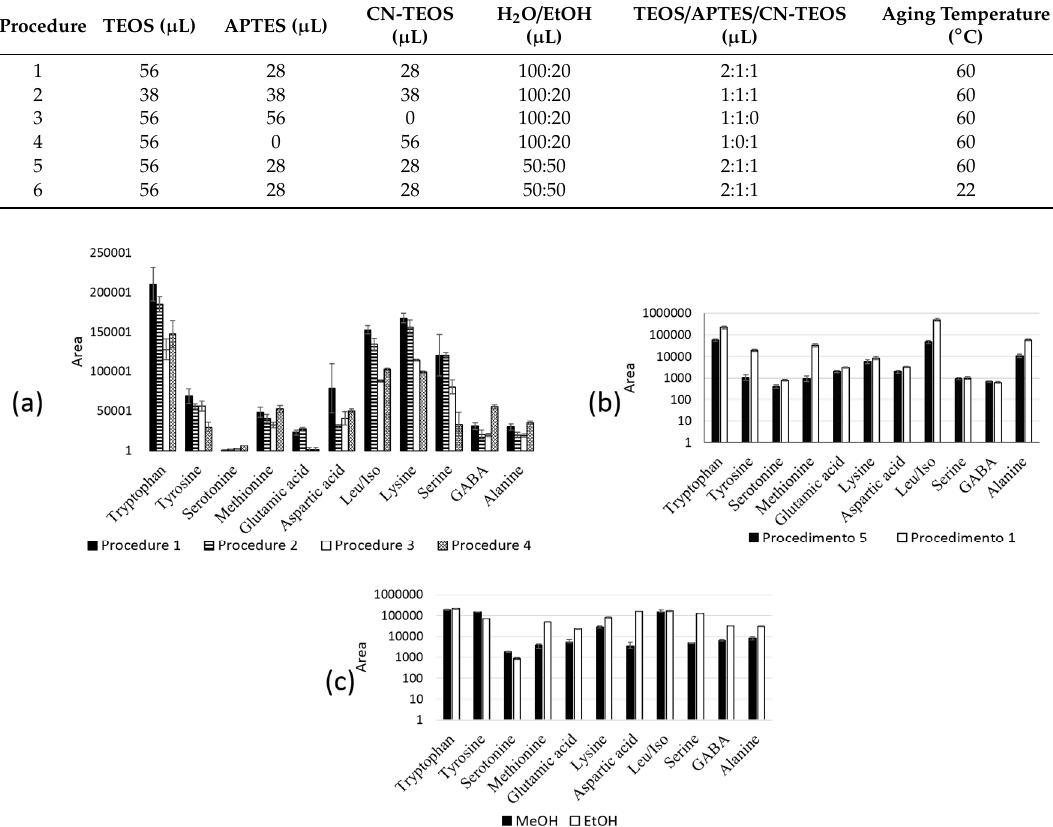
Figure 1. Optimization of the synthesis procedure (Table 1); ( a ) Molar ratios of the precursors TEOS / APTES / CN-TEOS, procedure 1 (2:1:1 v / v / v ); procedure 2 (1:1:1 v / v / v ); procedure 3 (1:1:0 v / v / v );